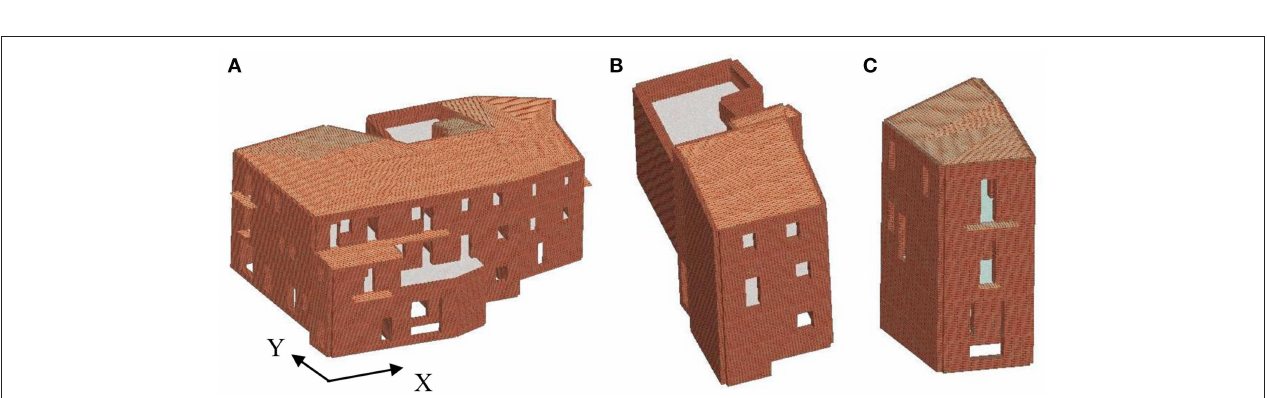
FIGURE 7 | Macro-element modeling: the whole cluster (A) and S.U. 8B (B) and 8C (C) .